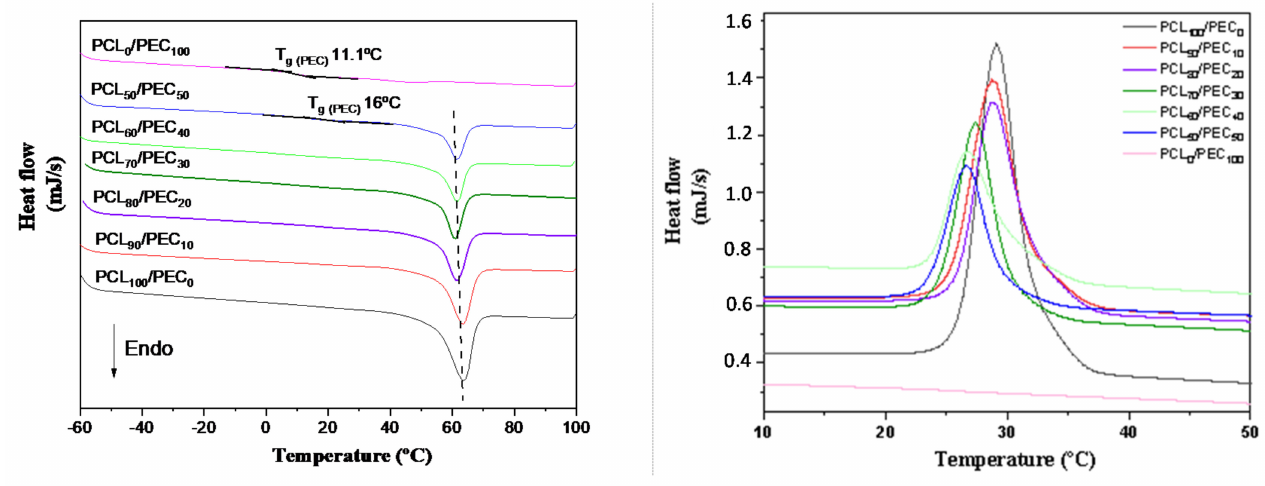
Figure 3. DSC curves obtained by heating to 100 ◦ C at 10 ◦ C/min in a first scan and maintaining the temperature for 7 min. Then, the samples were cooled to − 60 ◦ C ( right graph ) and the temperature was increased to 100 ◦ C at 10 ◦ C/min rate under nitrogen atmosphere in a second scan ( left graph ) to determine the melting temperature and crystallinity index of the PCL/PEC membranes. Table 3. DSC data obtained in terms of melting temperature (Tm), crystallization temperature (Tc) and glass transition temperature (Tg). % Crystallinity index was obtained using the standard enthalpy of 100% crystalline of PCL ( ∆ H m0 = 139.5 J/g) [29].